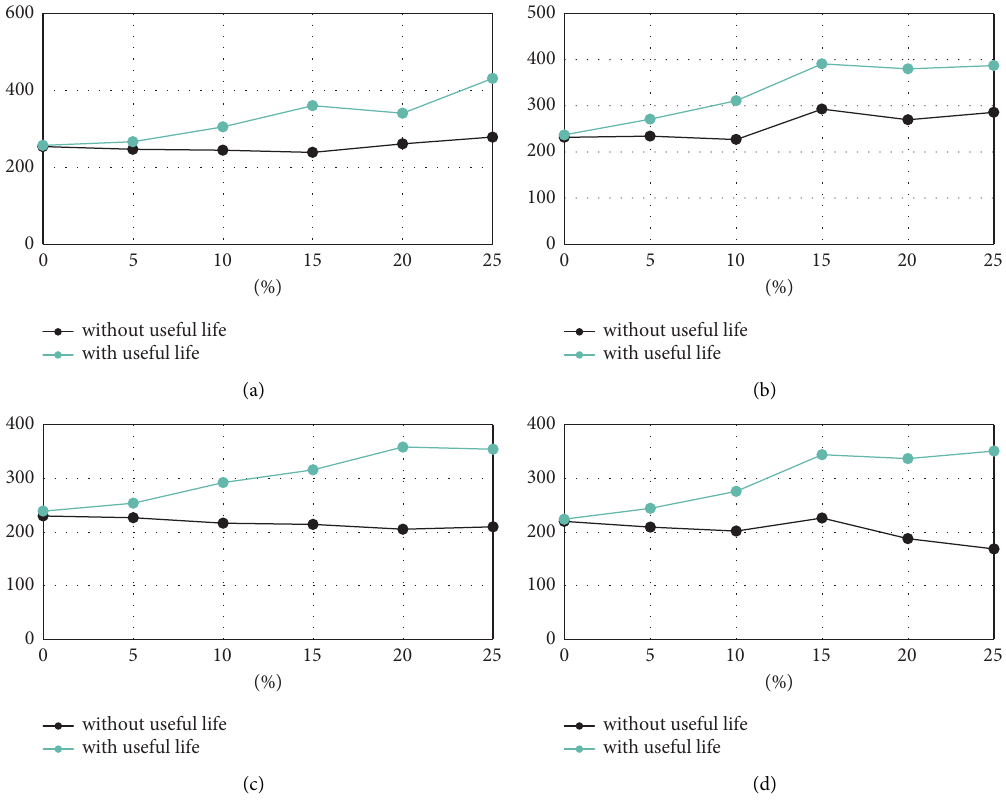
Figure 15: Useful lifetime risk evolution, from 0% to 25% of tolerance factor e . (a) Case study 1. (b) Case study 2. (c) Case study 3. (d) Case study